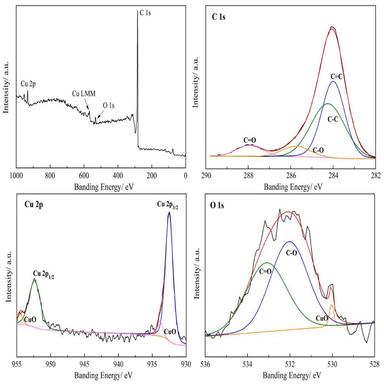
XPS of the Cu/graphite composite material.